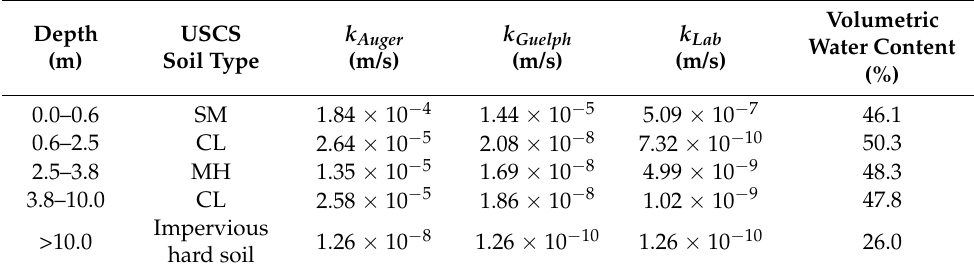
Table 2. Soil properties used in transient seepage